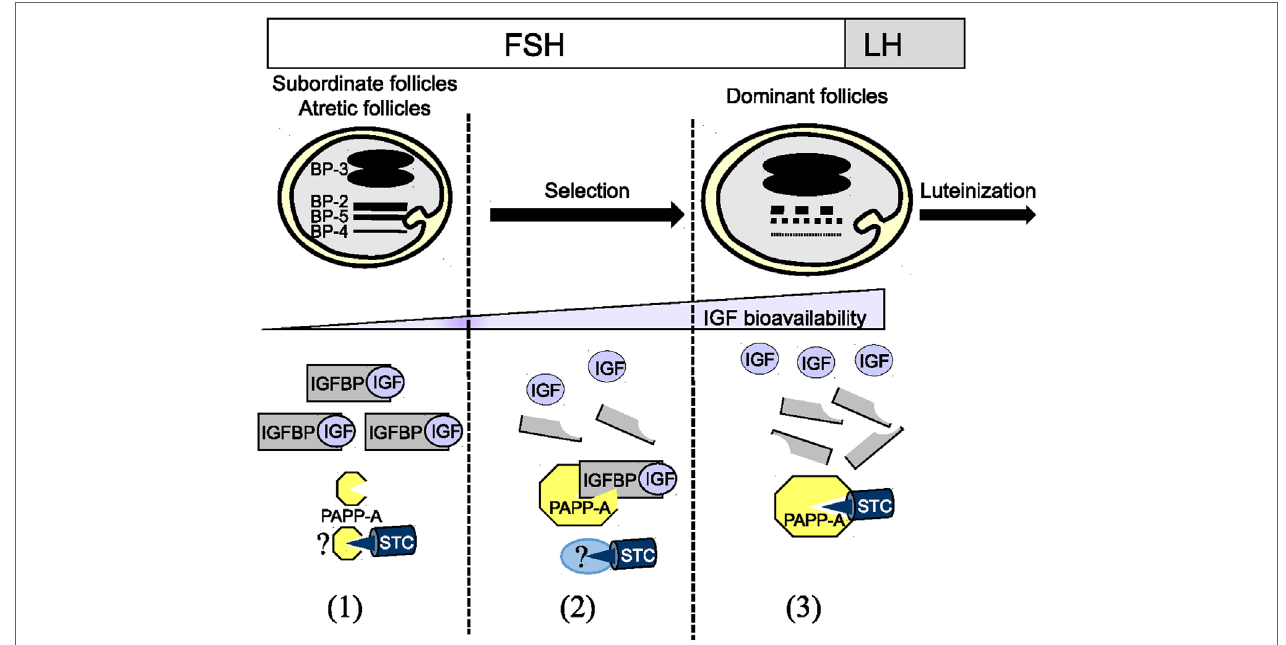
FiGURe 1 | Dynamic of the insulin-like growth factor binding protein (IGFBP) system during folliculogenesis (1) High concentrations of IGFBP-2, IGFBP-4, and IGFBP-5 in follicular fluid of subordinate and atretic follicles lead to a low IGF bioavailability. The absence of IGFBP proteolytic degradation is due to the low expression level of PAPP-A and potentially to its association with the inhibitor STCs STC1/2. (2) During terminal follicular growth under FSH control, the decrease in IGFBP-2, IGFBP-4, and IGFBP-5 is due to a decrease in IGFBP mRNA expression and an increase in the proteolytic degradation by PAPP-A in follicular fluid. This decrease might participate in the selection of dominant follicles. At this stage, PAPP-A expression and activity are maximal. Surprisingly, the inhibitor STC1/2 is coexpressed with PAPP-A suggesting that STC1/2 activity could be neutralized by a partner to allow PAPP-A full activity. (3) Just before ovulation, after LH stimulation, PAPP-A activity is reduced likely through its association with